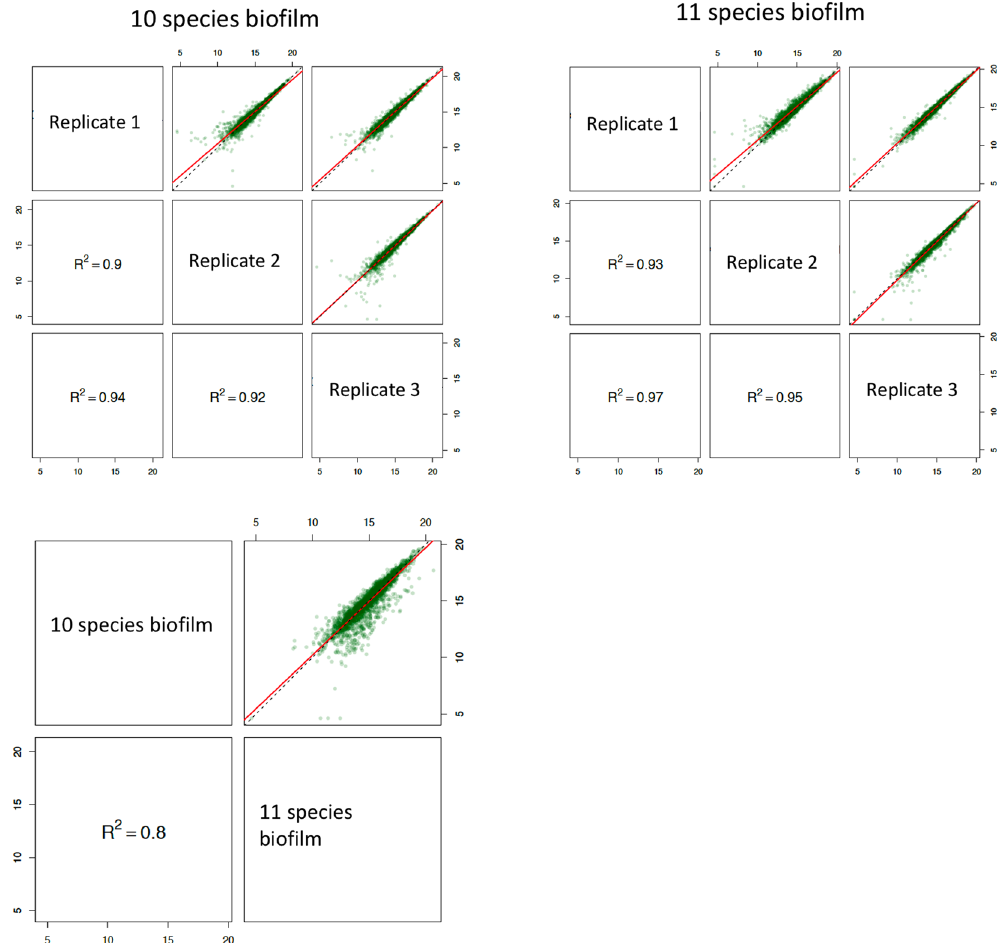
Figure 3. Quality control of the label-free quantitation data. Squared Pearson correlation coefficients of integrated peptide feature intensities are displayed for the comparisons within (n = 3) and between the two biofilm groups. The linear regressions of the integrated peptide feature intensities in different experimental group conditions are indicated in red, whereas the dashed lines correspond to direct